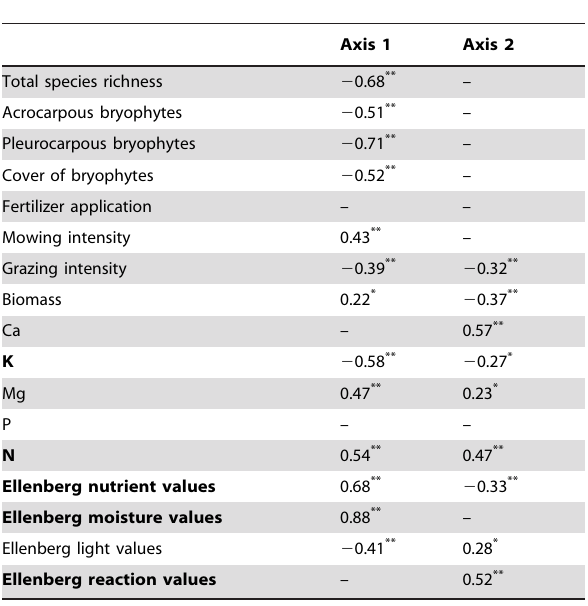
Table 3. Spearman correlations of CCA-axes and environmental